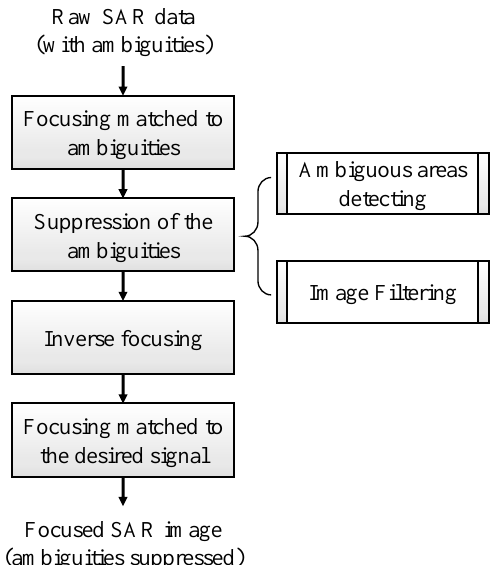
Figure 3. Block diagram showing the processing steps of the DFPP technique for suppressing the ambiguities.